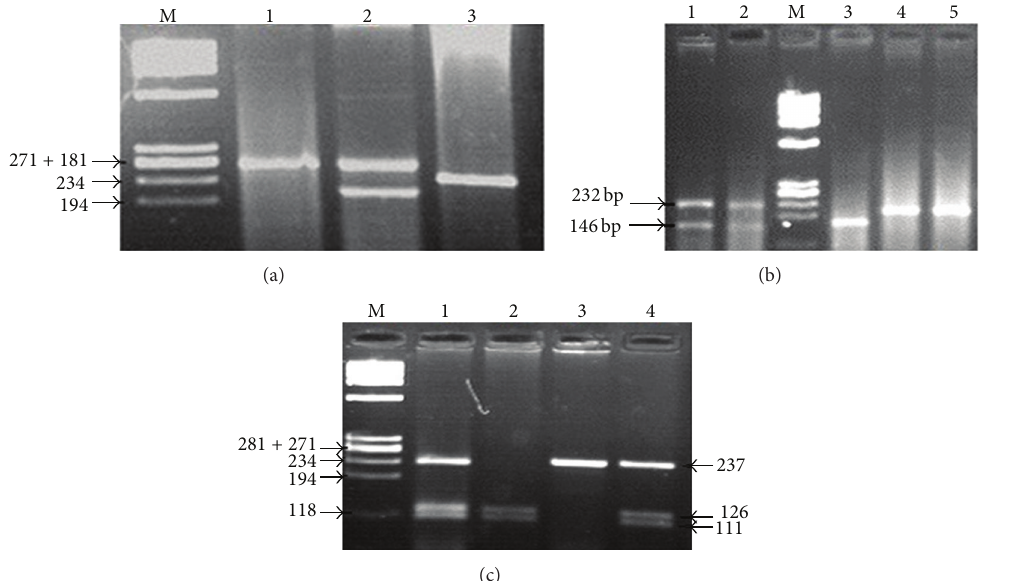
Figure 1: Genotyping of MAOA / B and DRD2 . (a) Different VNTRs of MAOA . M indicates DNA marker ( 𝜑 x174). Lane 1 indicate 5 tandem repeats at 269 bp. Lane 2 indicates 3 and 5 tandem repeats at 209 and 269 bp. Lane 3 indicates 4 tandem repeats at 239. (b) PCR-based RFLP of MAOB . M is DNA marker ( 𝜑 x174). Lanes 1 and 2 indicate AG genotype at 232 and 146bp (86 bp not shown). Lane 3 indicates AA genotype at 146bp. Lanes 4 and 5 indicate GG genotype at 232 bp. (c) PCR-based RFLP of DRD2 . Lanes 1 and 4 indicate A1A2 genotype at 237, 126, and 111bp. Lane 2 indicates A2A2 genotype at 126 and 111. Lane 3 indicates A1A1 genotype at 237